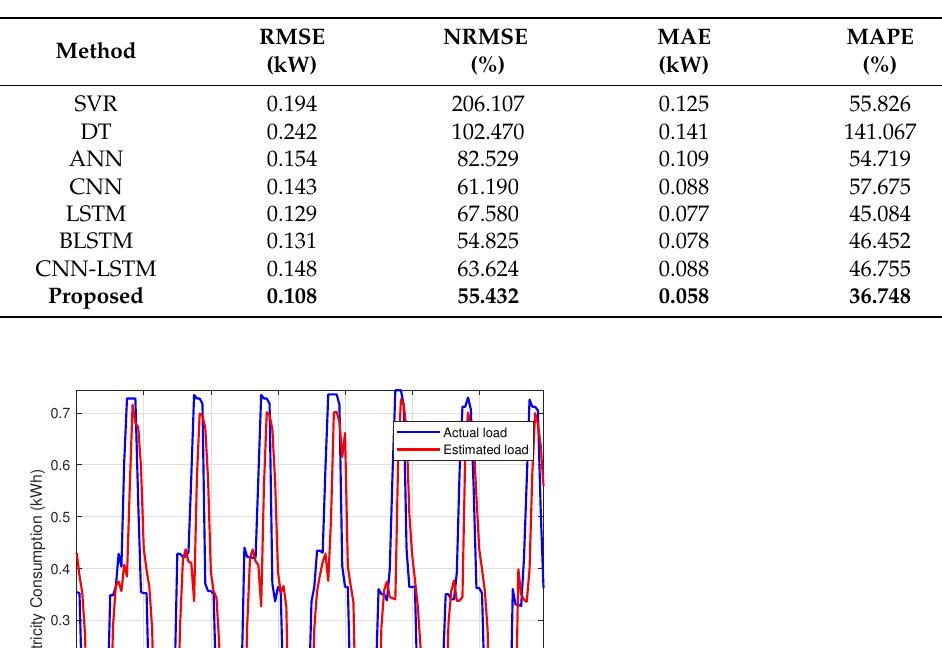
Table 3. Performance of different machine learning and deep learning models.